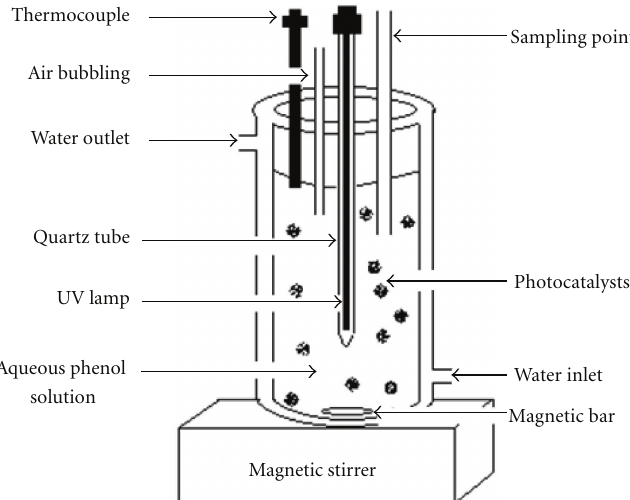
Figure 3: A schematic diagram of batch reactor.